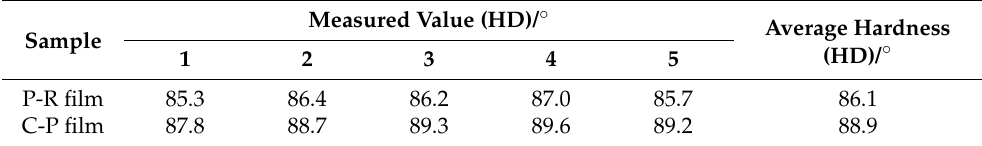
Table 1. Comparative analysis of the hardness of P-R and C-P